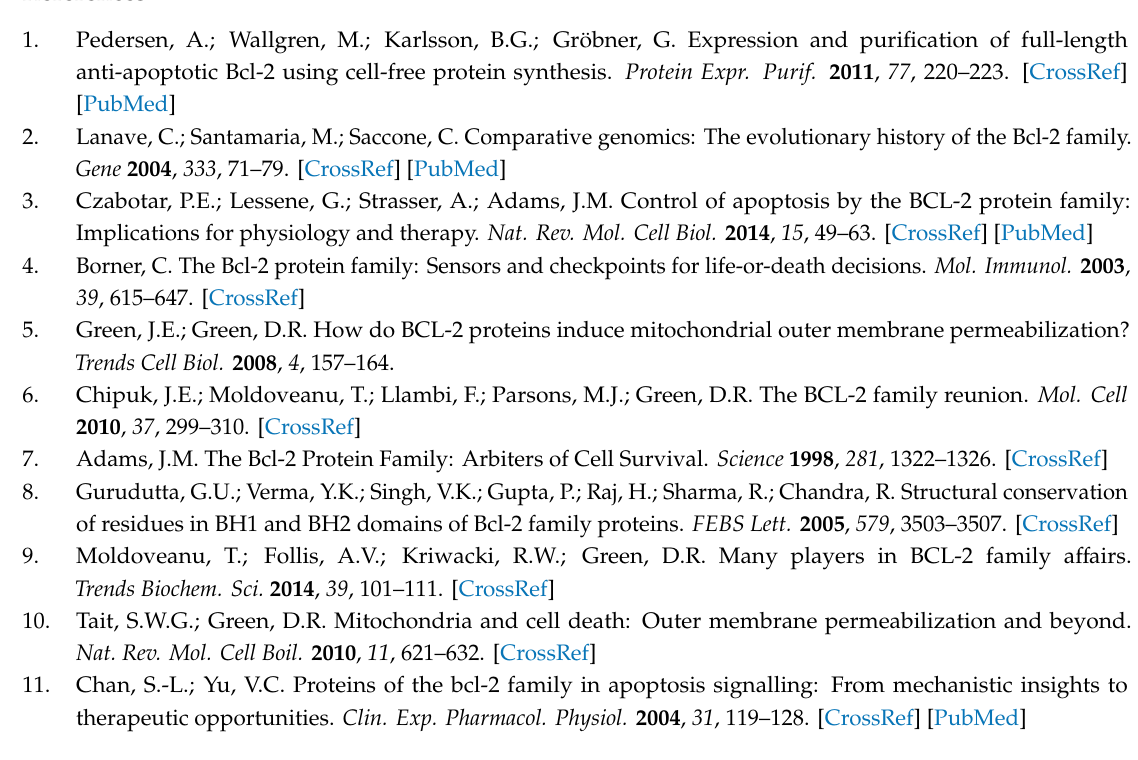
Figure S1: Diagonally symmetric table showing the superposition of initial structures and two assessments of RMSD and RMSDr. The RMSDr values were calculated, including 5 cycles of refinement to reject structural outliers. Images and RMSD values were obtained by Pymol. The distances between aligned C-alpha atom pairs are stored as B-factors of these residues, which are dyed by a color spectrum, with blue specifying the minimum pairwise RMSD and red indicating the maximum. Unaligned residues are colored gray. Figure S2: Representative snapshots of the conformational changes observed at 310, 400, and 500 K for Bcl-2 followed each 20 ns. Figure S3: Representative snapshots of Bcl-2 ∆ TM, along MD simulations at 310, 400, and 500 K, followed each 20 ns. Figure S4: Representative snapshots of the conformations adopted by Bcl-2A1 observed each 20 ns of MD simulation at 310, 400, and 500 K. Figure S5: Characteristic snapshots of Bcl-2A1 ∆ TM observed each 20 ns of MD simulation at 310, 400, and 500 K. Figure S6: Radius of gyration (RG) of structures A) Bcl-2; B) Bcl-2 ∆ TM; C) Bcl-2A1 and D) Bcl-2A1 ∆ TM as a function of simulation time. Figure S7: Solvent accessible surface area (SASA) of A) Bcl-2; B) Bcl-2 ∆ TM; C) Bcl-2A1 and D) Bcl-2A1 ∆ TM, with respect to simulation time. The color code defined for the di ff erent temperatures is shown. Figure S8: Hydrogen bonds (Donor-Acceptor within a cut-o ff distance of 0.35 nm and angle of 30 ◦ ) of A) Bcl-2; B) Bcl-2 ∆ TM; C) Bcl-2A1 and D) Bcl-2A1 ∆ TM, as a function of simulation time. The color code for each temperature is shown. Figure S9: Contact maps formed between the residues of each of the proteins Bcl-2 (panels A, B and C); Bcl-2 ∆ TM (panels D, E and F); Bcl-2A1 (panels G, H and I), and Bcl-2A1 ∆ TM (panels J, K and L). They were calculated from the minimum distance matrix (0–1.5 nm). We show average values observed along the whole simulations at 310, 400, and 500 K. Figure S10: Prediction of protein disorder using the IUPred web server for A) Bcl-2 and B) Bcl-2A1. Figure S11: Porcupine plot of A) Bcl-2 and B) Bcl-2A1, illustrating the motion along the first eigenvectors (EV) obtained from PCA. The regions recognized as potential PEST sites in Bcl-2 and Bcl-2A1 were colored in green. Table S1 Descriptive data of clusters of conformations for each protein, at di ff erent temperatures. Ensemble of structures based on the RMSD using the clustering tool of GROMACS and the GROMOS clustering